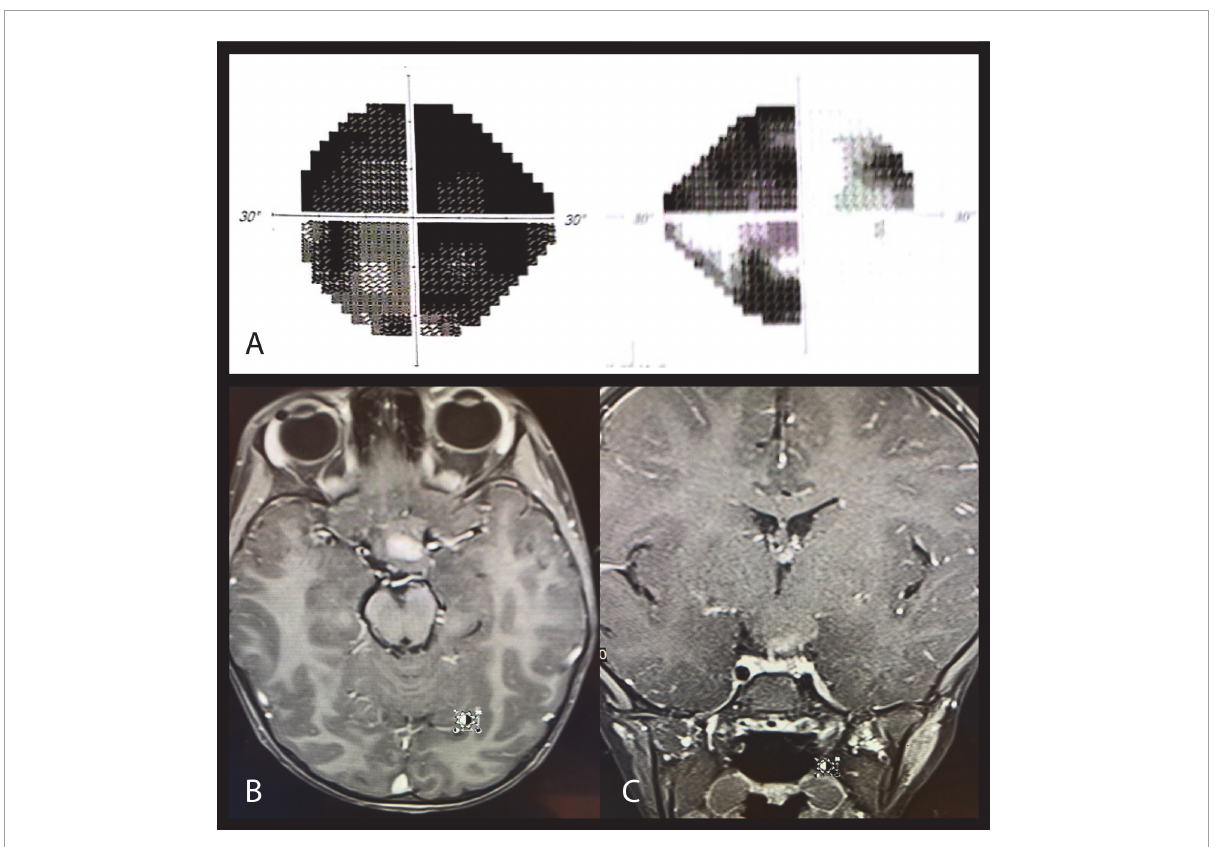
FIGURE5 Case 5. Automated perimetry demonstrating a nasal defect respecting the vertical meridian in the right eye and a severely damaged field on the left (A) . MRI T1 post contrast axial (B) and coronal (C) scans showing a large chiasmatic hypothalamic enhancing lesion extending to the left optic tract and the left pre-chiasmatic optic